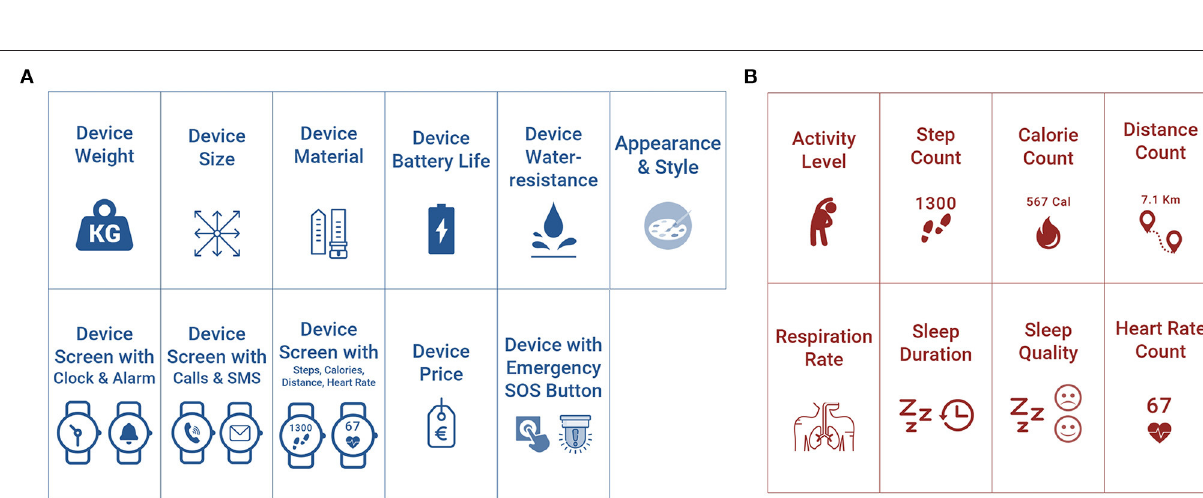
FIGURE 4 | The four wearable devices provided to the participants, as they are depicted on the device card set.